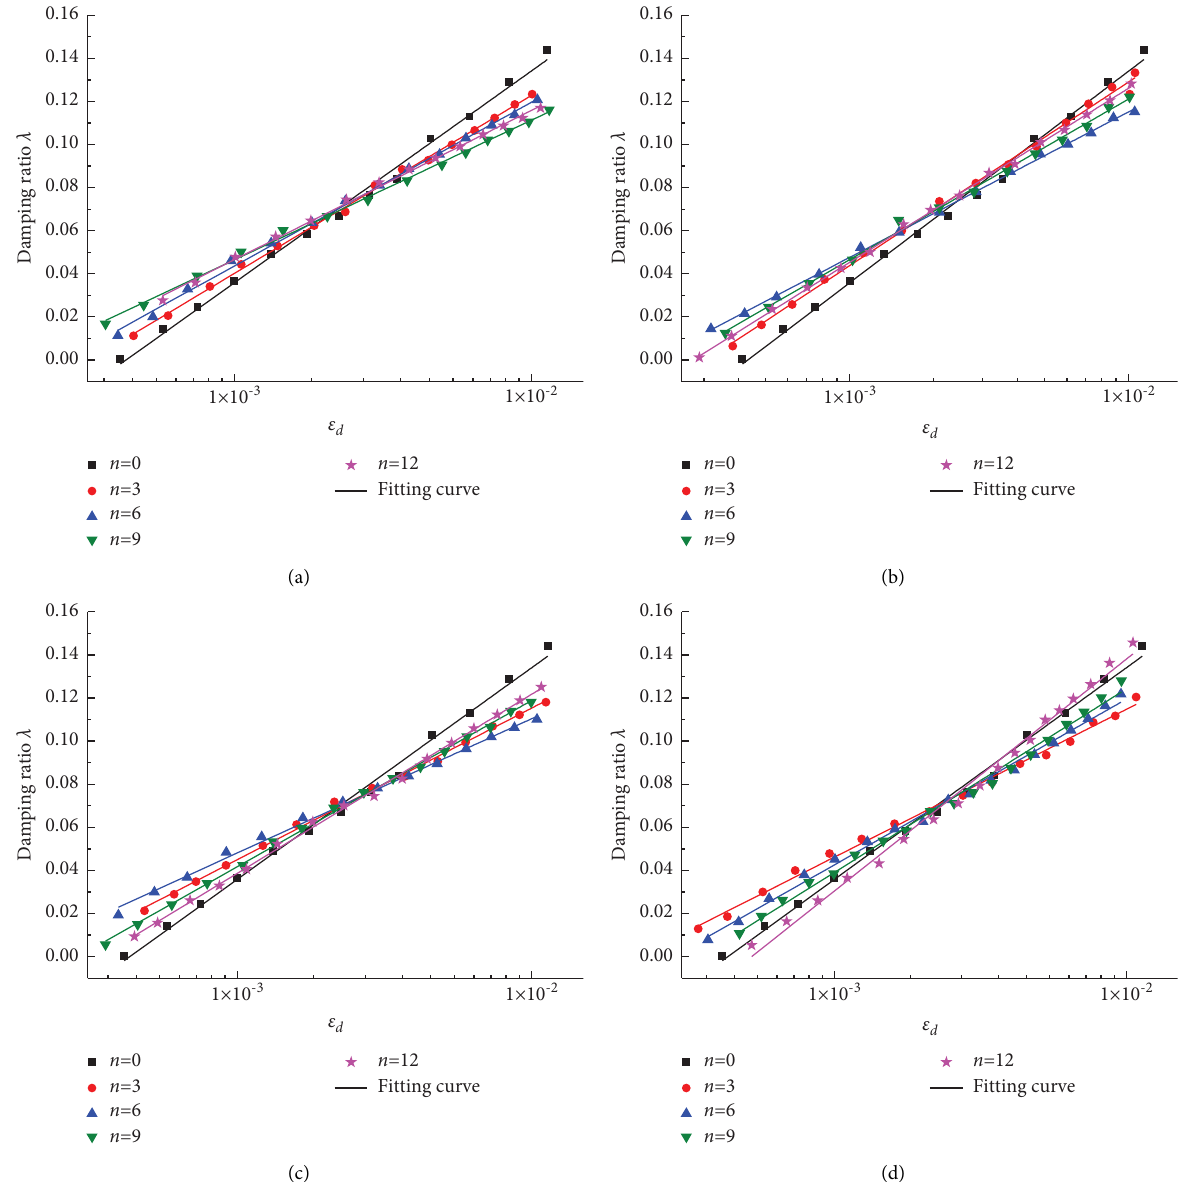
Figure 8: Te relationship between the damping ratio λ and dynamic strain ε f � 1Hz, N � 5). (a) W - D cycle path a . (b) W - D cycle path b . (c) W - D cycle path c . (d) W - D cycle path d